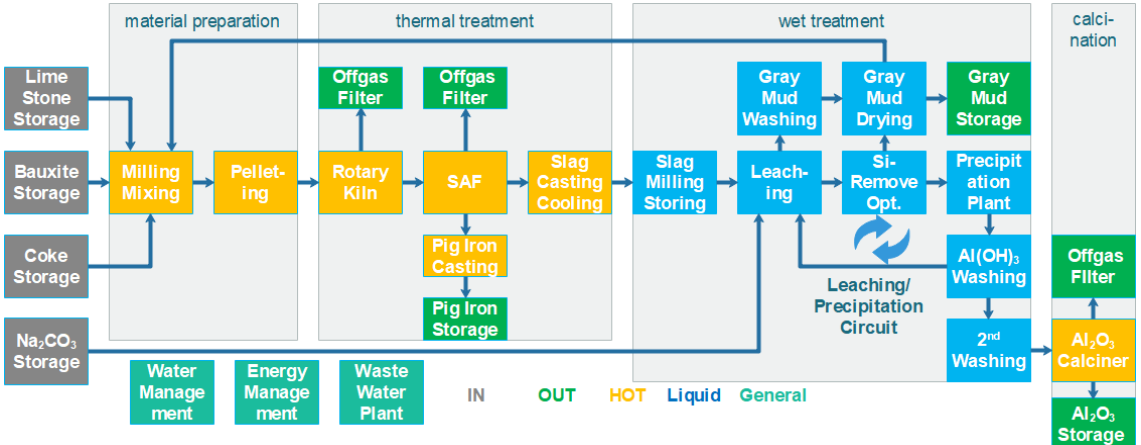
Figure 1. Block flow diagram of the reengineered Pedersen Process.